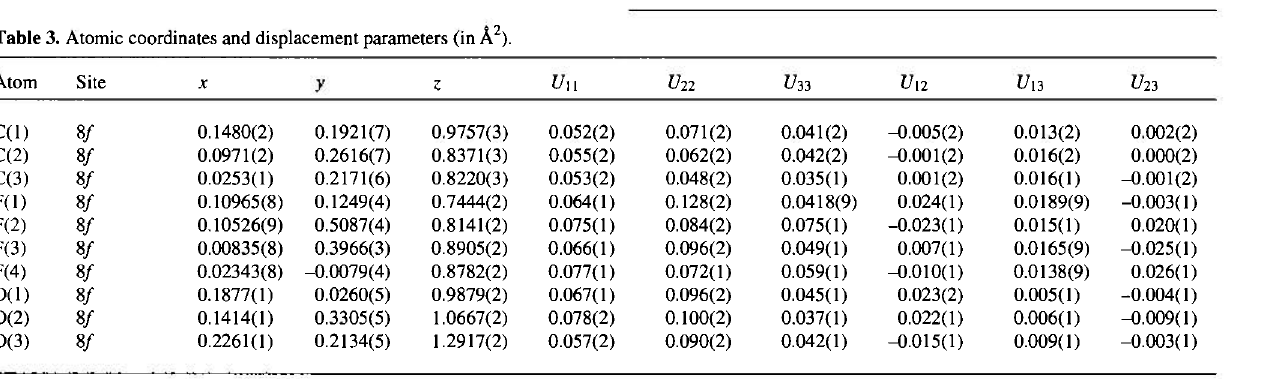
Table 3. Atomic coordinates and displacement parameters (in Ä 2 ).